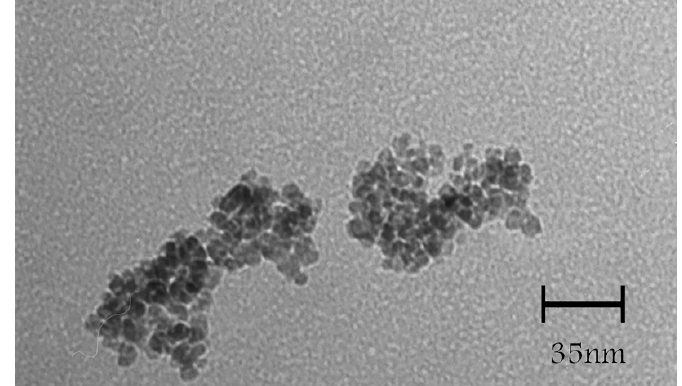
Figure 1. Transmission electron micrographs of L -lysine coated magnetite nanoparticles.